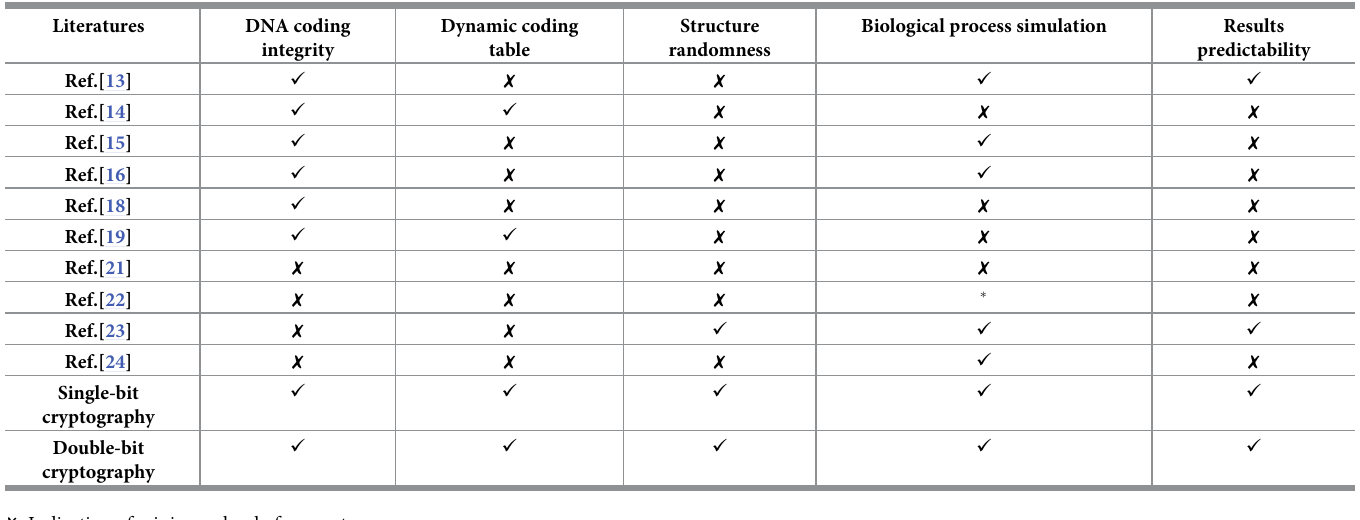
Table 5. Comparisons of existing